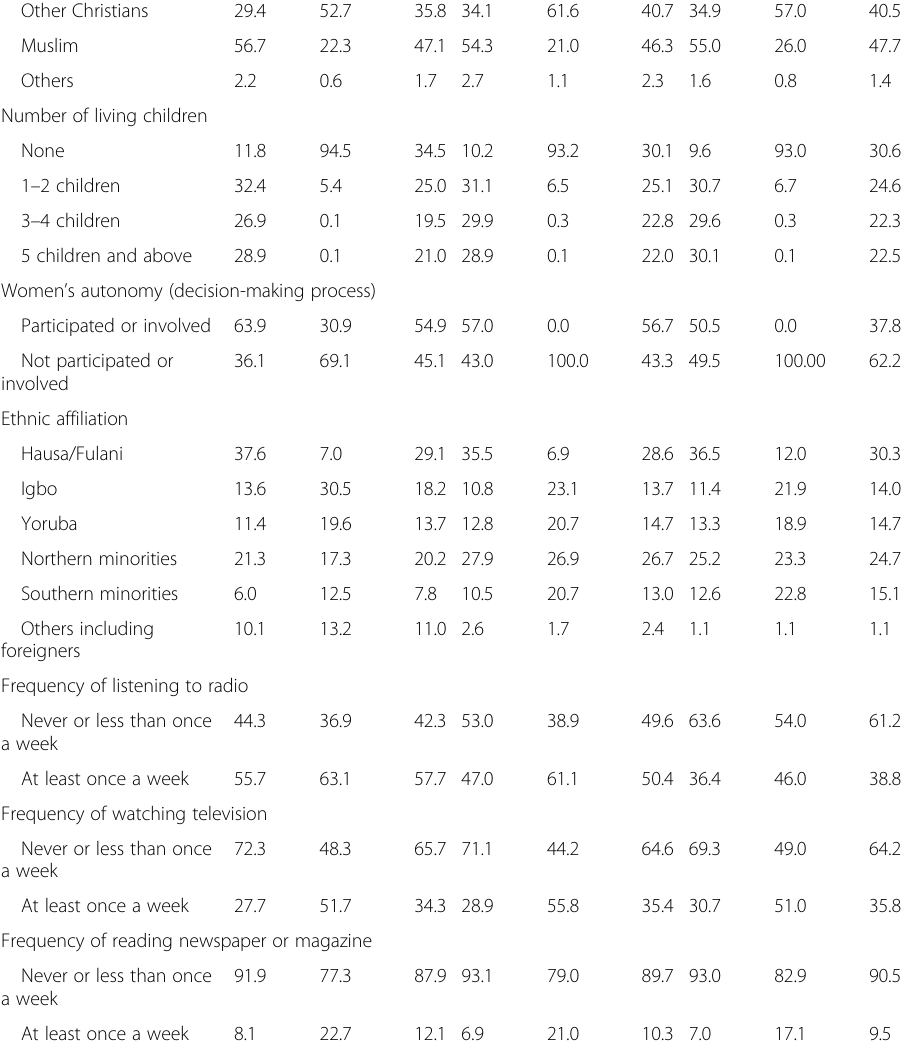
Table 1 Respondents ’ distribution according to demographic and socioeconomic